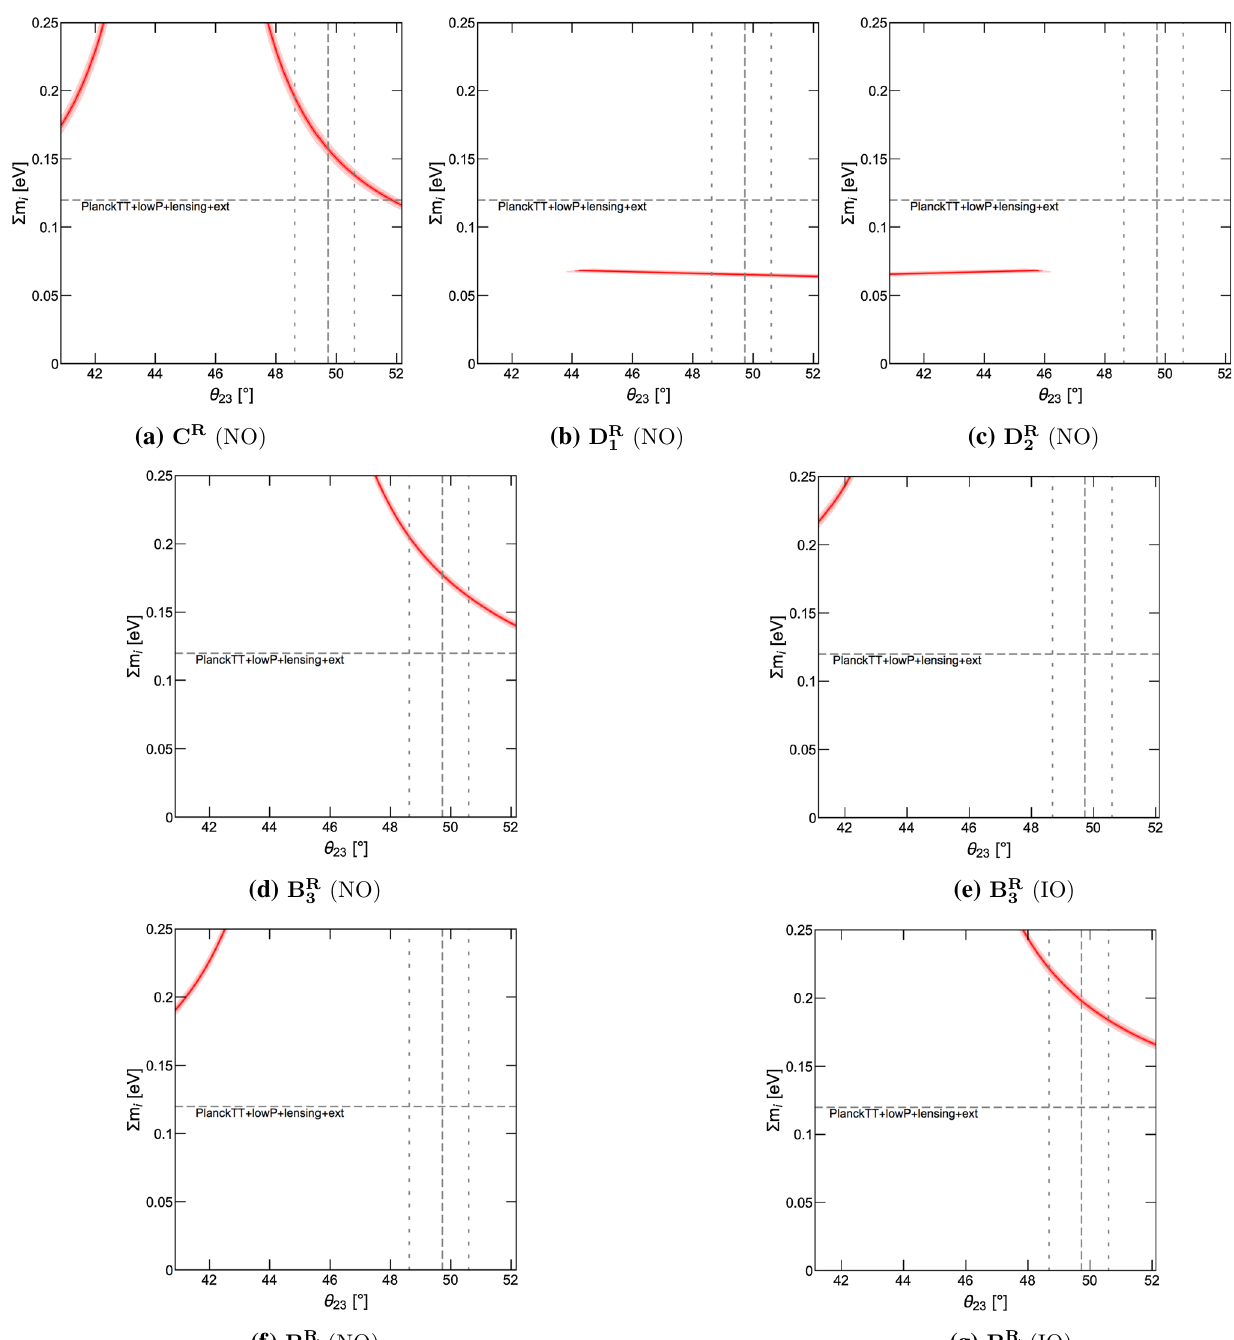
Fig. 2 The predictions for the sum of the neutrino masses in the singlet models. The red line shows the prediction as functions of θ 23 and the dark (light) red bands show the uncertainty coming from the 1 σ (3 σ ) errors of θ 13 and (cid:6) m 2 in the C R and the other structures, respectively. The vertical gray dashed line represents the best fit value of θ 23 and the